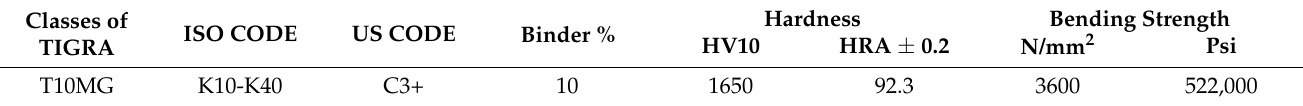
Table 3. Technical parameters of sintered carbide